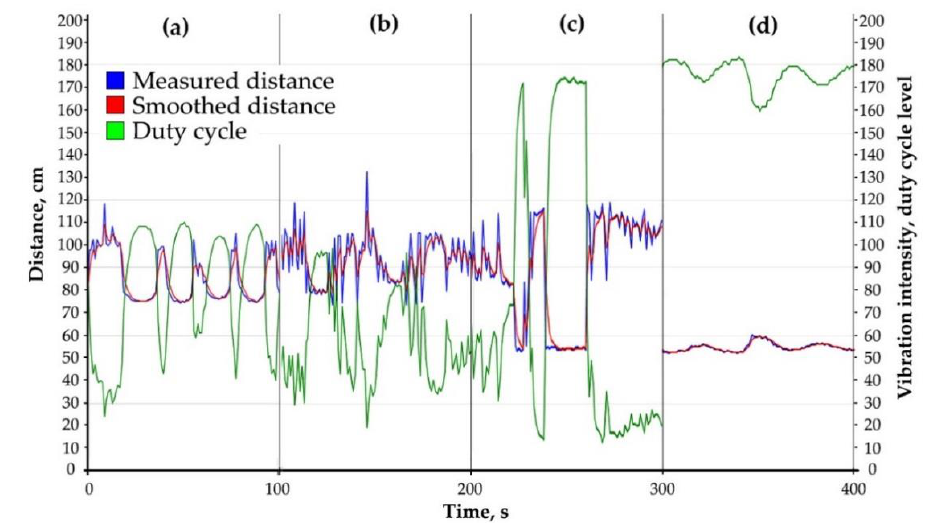
Figure 4. Calibration procedure of the duty cycle modulation based on hyperbolic tangent function (4): ( a ) Hand swinging; ( b ) Wall following; ( c ) Obstacle detection; and ( d ) Curbs tracking.